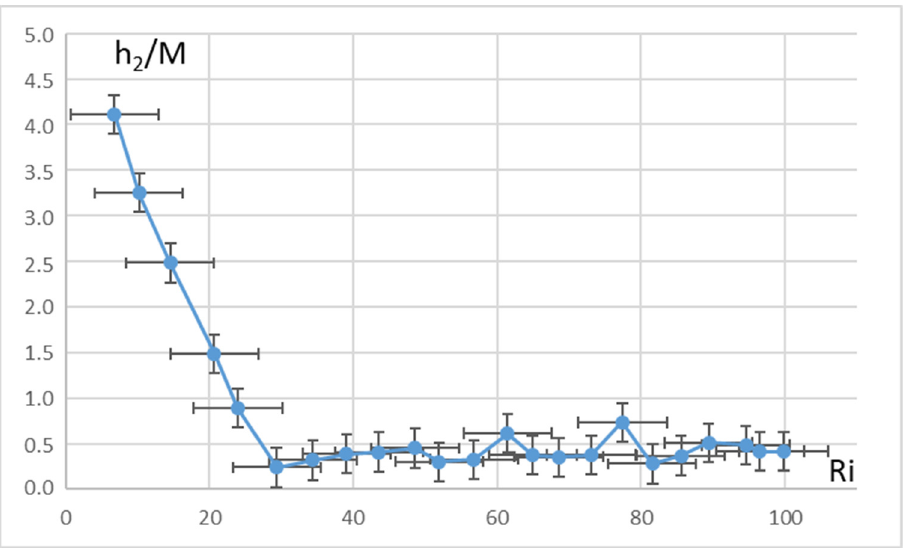
Figure 7. Dependence of h 2 / M on Ri for the experimental run with initial salinity difference ∆ S = 30 ppm, Ri initial = 100, and Re = 214. The bars are standard errors of